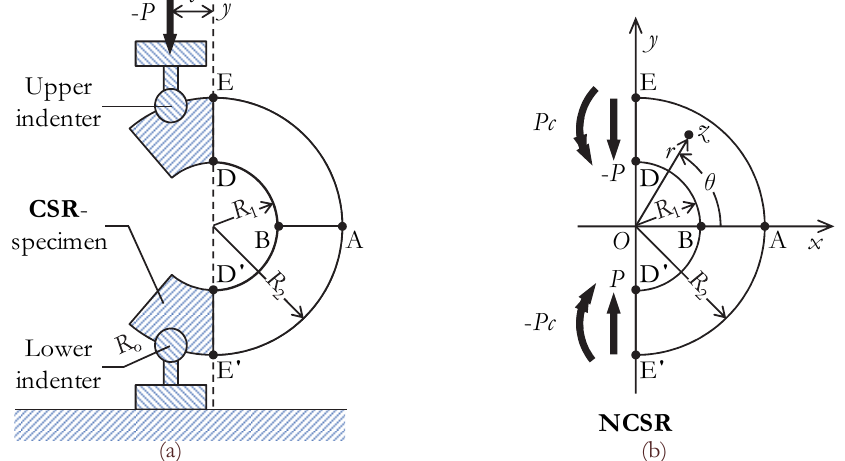
Figure 1: (a) The configuration proposed for the experimental implementation of the CSR-test; (b) The NCSR configuration considered in the analytic solution of the